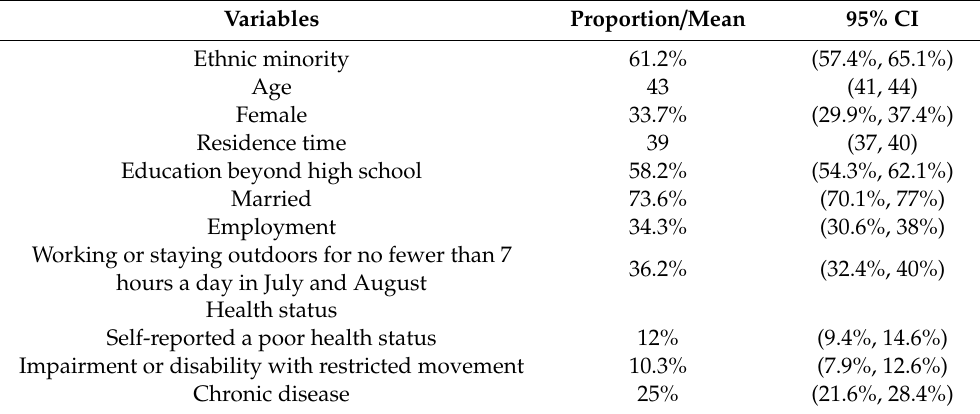
Table 1. Main characteristics of the participants. CI: confidence interval.